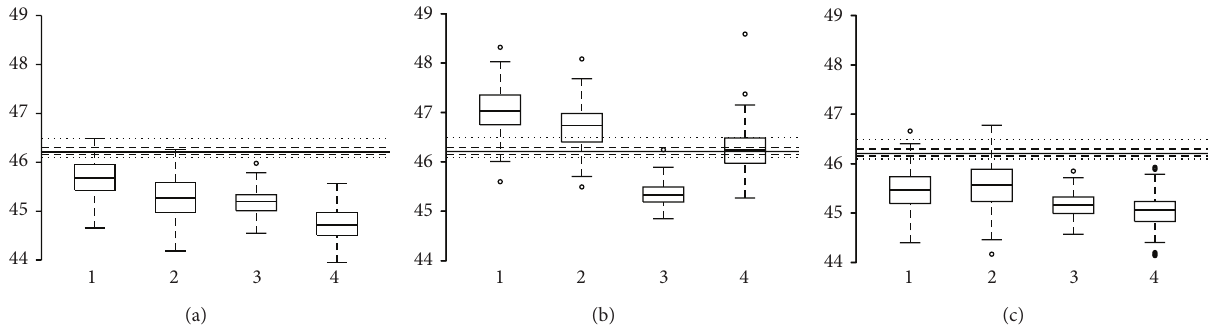
Figure 4: Boxplots of the 100 RMSE of the models predicting stagnic layer thickness. (a) 10m terrain resolution, (b) 20 m terrain resolution, and (c) 30 m terrain resolution. 1 = default Random Forest parameters, 2 = additional predictor selection, 3 = 1, 2+ tuning of sampsize, and 4 = 1, 2+ tuning of mtry. The lines refer to the boxplot parameters of the RMSE distribution of the mean of the data as prediction model. Solid line: median, dashed line: upper/lower hinges, and dotted line: upper/lower whiskers.